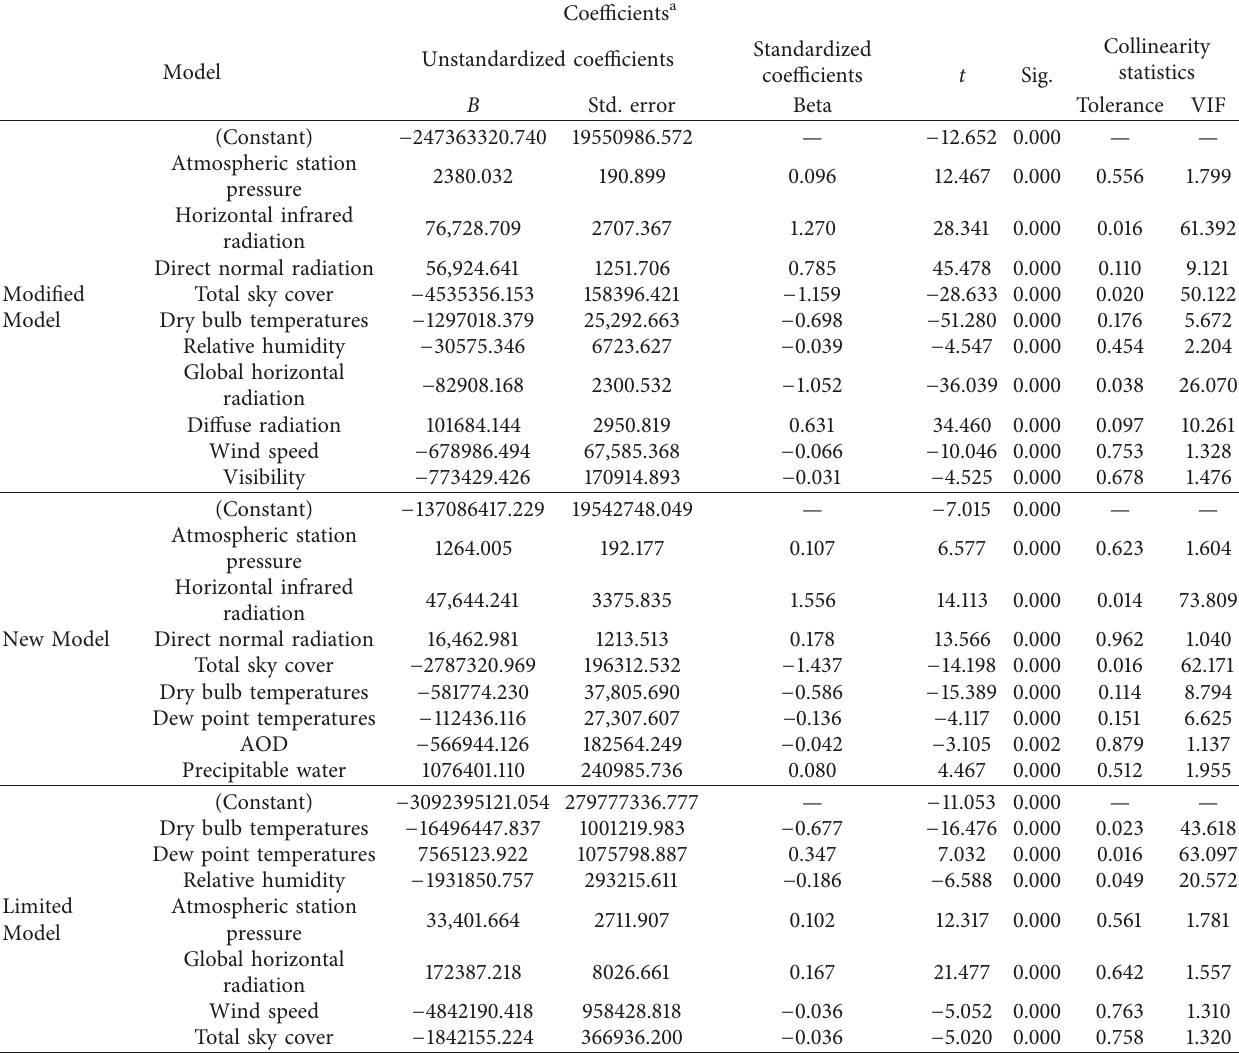
Table 25: Regression coefficients for a DOE large office building depending on different